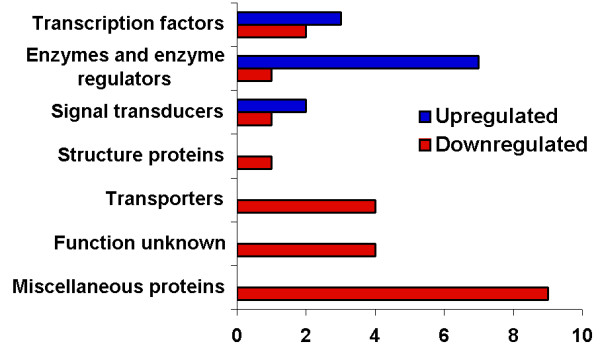
Gene ontology of coregulated genes by both DPP and activin signaling pathways. The X-axis indicates the number of genes in each group.